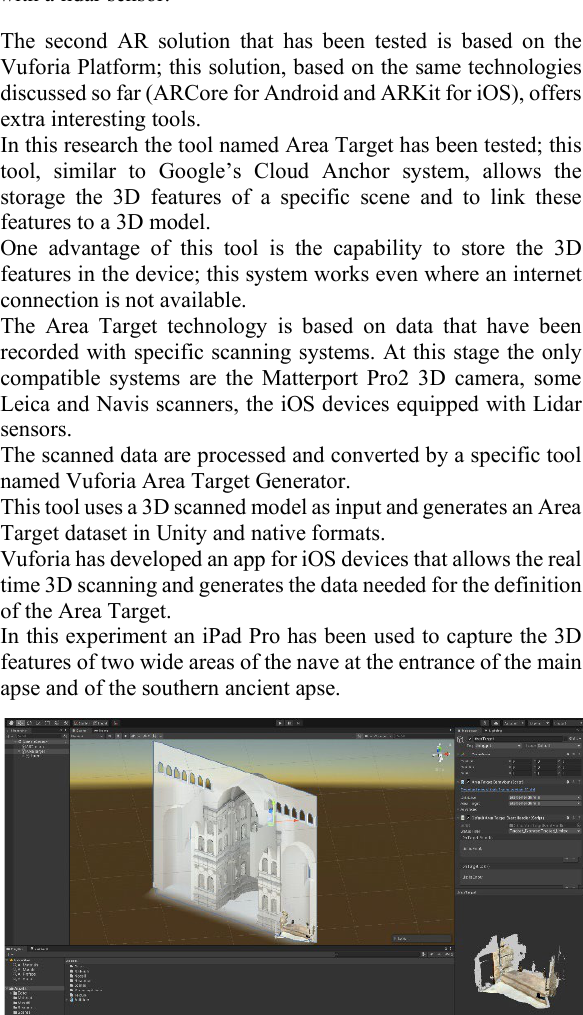
Figure 9. Southern ancient apse: 3D features recording with Vuforia Area Target Creator installed on an iPad Pro equipped with a lidar sensor.